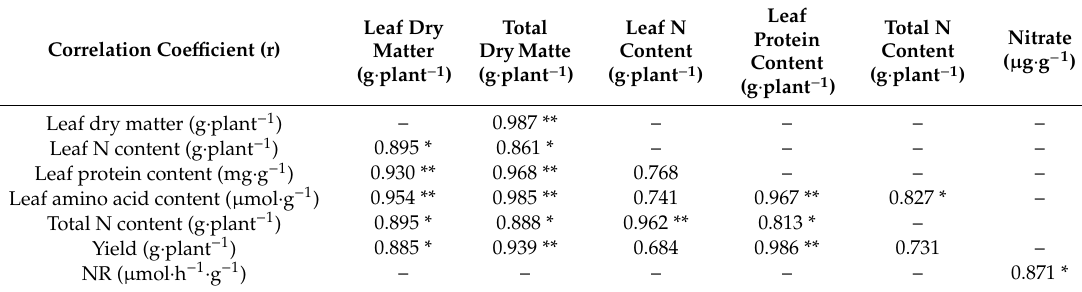
Table 4. Correlations between di ff erent